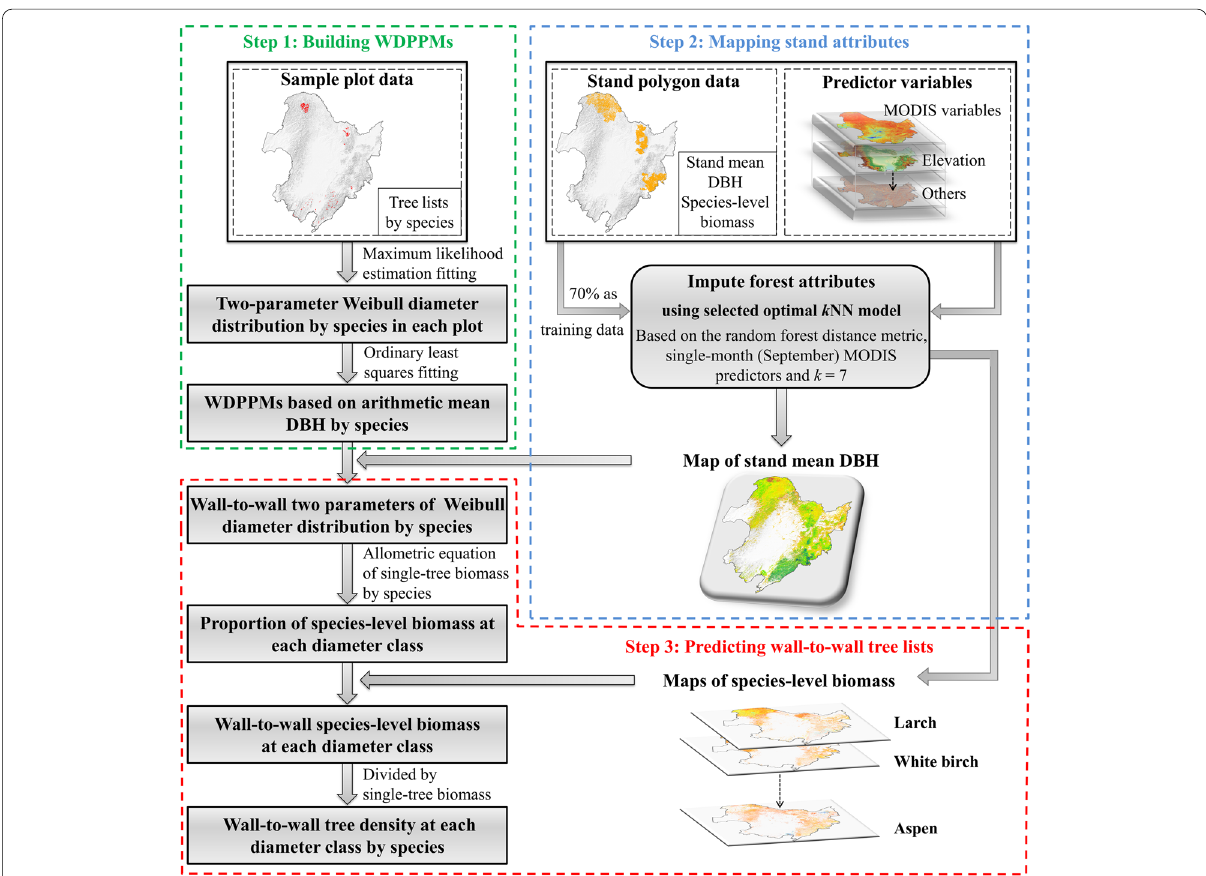
Fig. 2 Workflow adopted for predicting the wall-to-wall tree lists over the forest region of Northeast China. WDPPM S , Weibull distribution parameter prediction models; DBH, diameter at breast height; k NN, k -nearest neighbor. The maps of species-level biomass were obtained from our previous study (Fu et al.